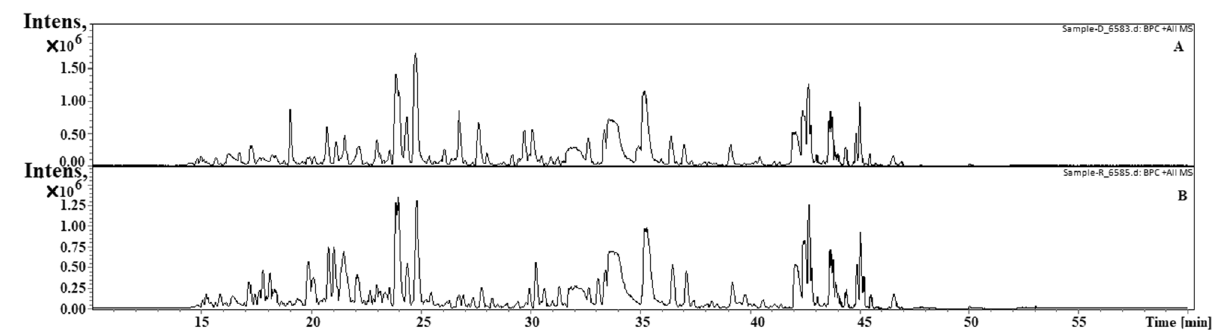
Table 3. Identification of DNase I and RNase molecules after comparison of LC–MS (AuNPs-enzymes) output list with the UniProt database.